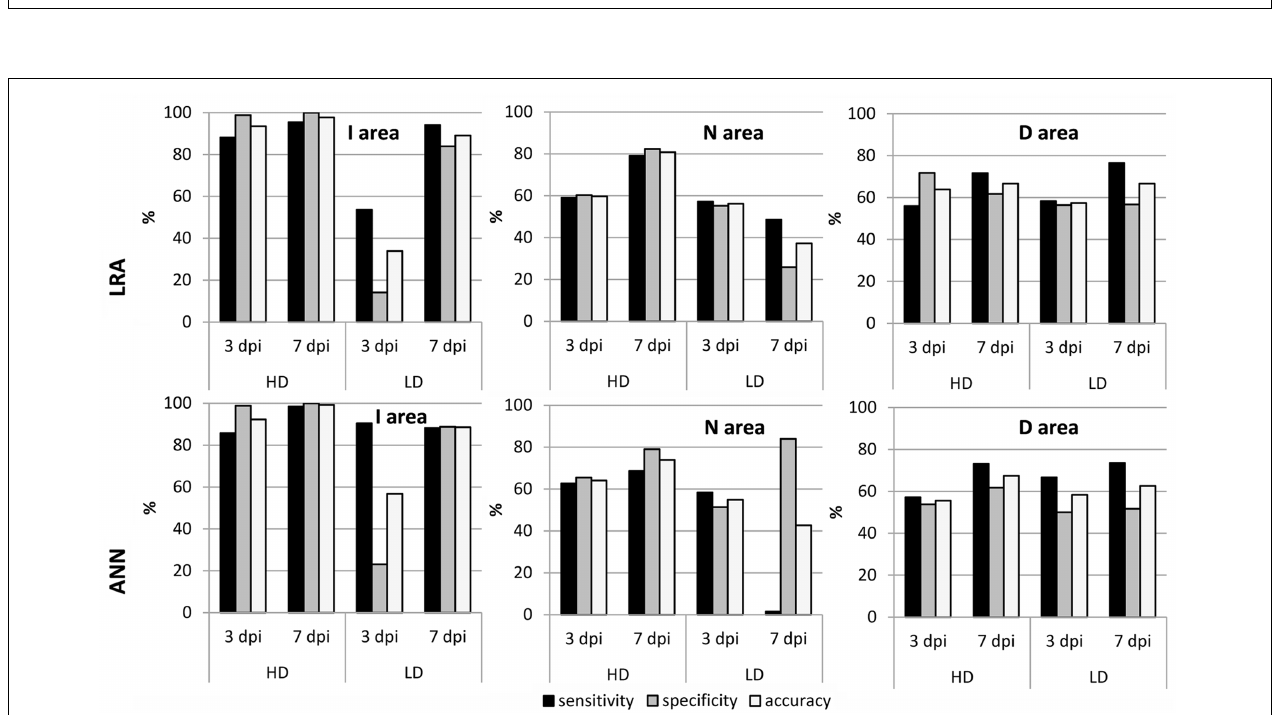
FIGURE 5 | Sensitivity, specificity, and accuracy of the zucchini models applied to melon. The best fits obtained for zucchini (by LRA and ANN) were applied to the corresponding areas of melon leaves LD and HD-inoculated with D. dadantii .